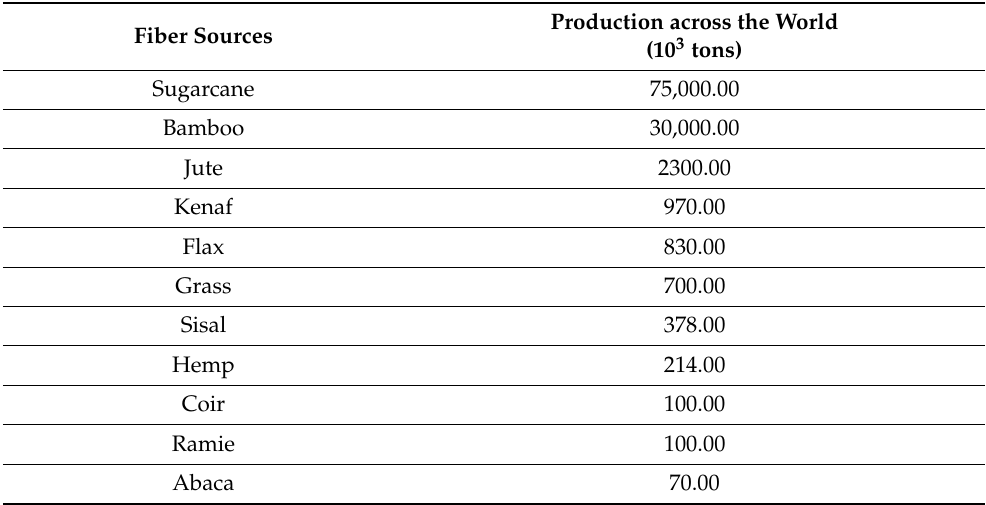
Table 1. Commercially significant fiber sources and gross production across the world [36], with permission from Elsevier, 2012.